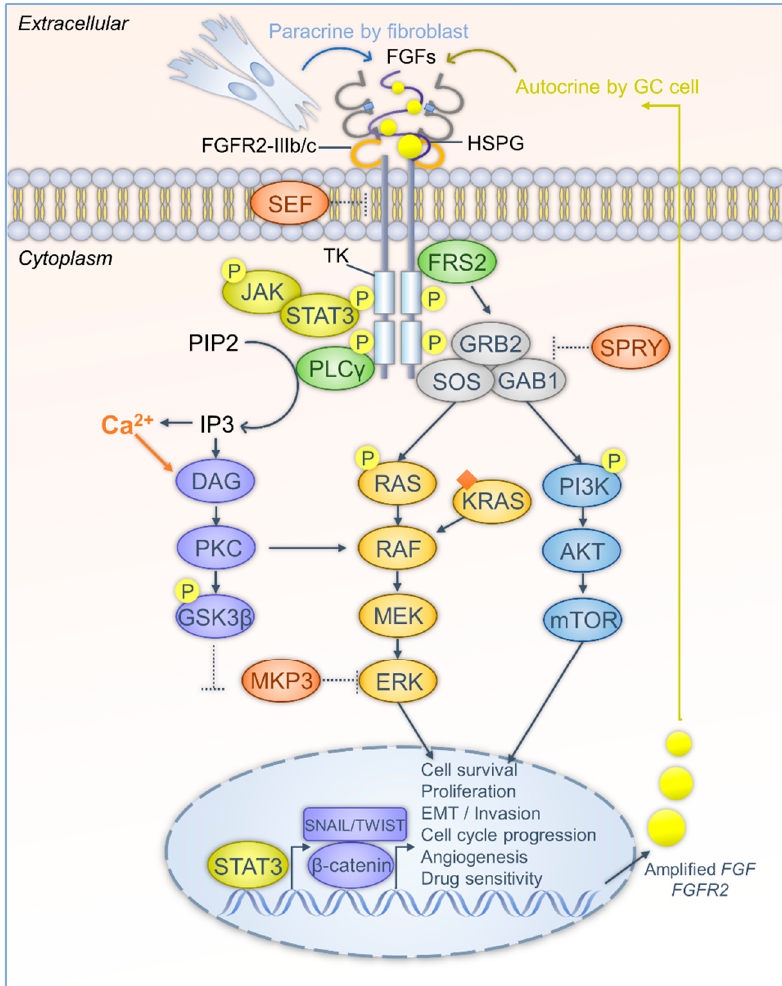
Figure 1. The FGF-FGFR cascade interplays with the downstream signaling network in GC progression. Firstly, FGFR is aberrantly activated in GC cells. FGFs can be released mainly in two manner by gastric fibroblasts, and in an autocrine manner from cancer cells. Gene amplification of FGFs and FGFRs leads to overproduction of FGFs and FGFRs. FGFs are stabilized and bind to FGFR